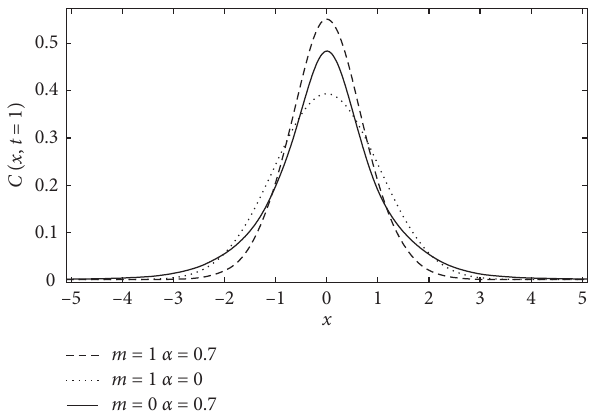
Figure 1: The probability density function C ( x, t ) with different m and α . Here, v � 0, D � 0 . 5, β � 1, and t �